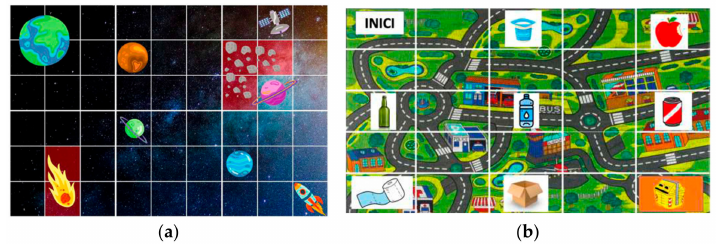
Figure 6. ( a ) Carpet in the design of team A1. ( b ) Carpet in the design of team